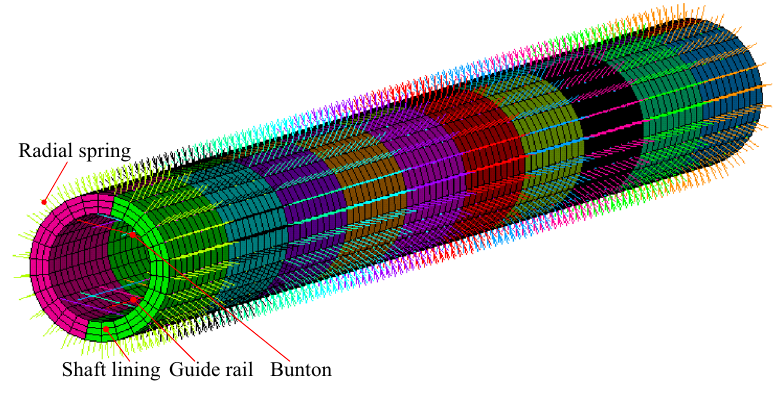
Figure 4. Finite element model based on spring element of SRSM under